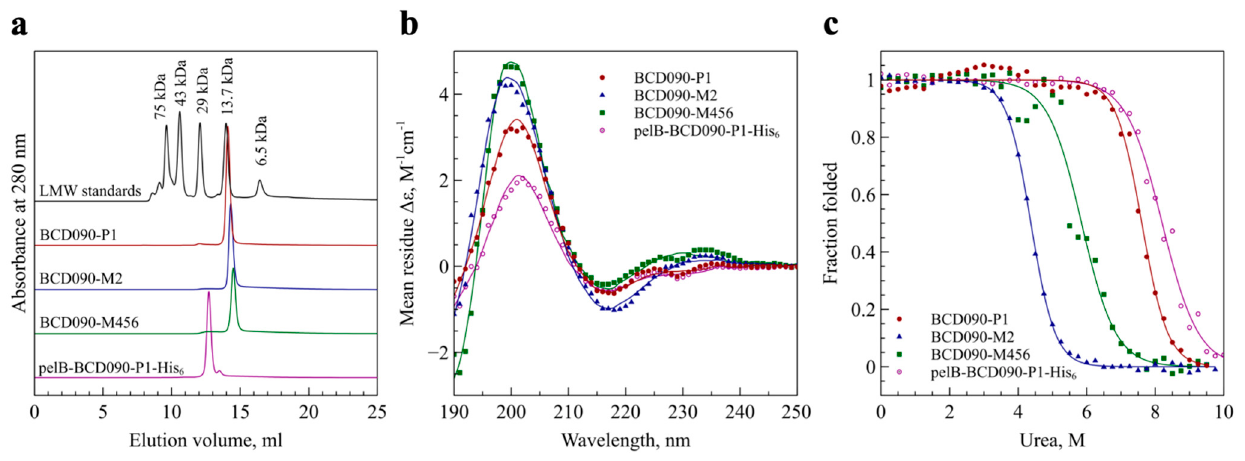
Figure 2. Biochemical characterization of the anti-ErbB3 single-domain antibodies. ( a ) Size exclusion chromatography shows that all antibodies are present as monomers of expected molecular weight; pelB-BCD090-P1-His 5 elutes earlier due to the presence of the leader peptide and a histidine tag; ( b ) circular dichroism spectroscopy of the single-domain antibodies, experimental data points are shown as symbols and fitted curves shown as lines. Deconvolution of the spectra gives a secondary structure with prevalent antiparallel β -sheets and turns, typical of immunoglobulin fold; ( c ) experimental urea denaturation curves of the single-domain antibodies (symbols) and their fits with the two-state folding model (lines). All three antibodies show remarkable stability with denaturation midpoints above 4 M urea.